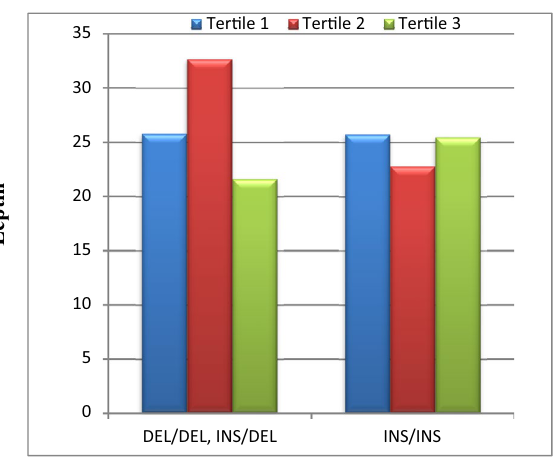
Figure 2. Interaction between Apo B INS/DEL SNP and DQI-I on serum leptin level.